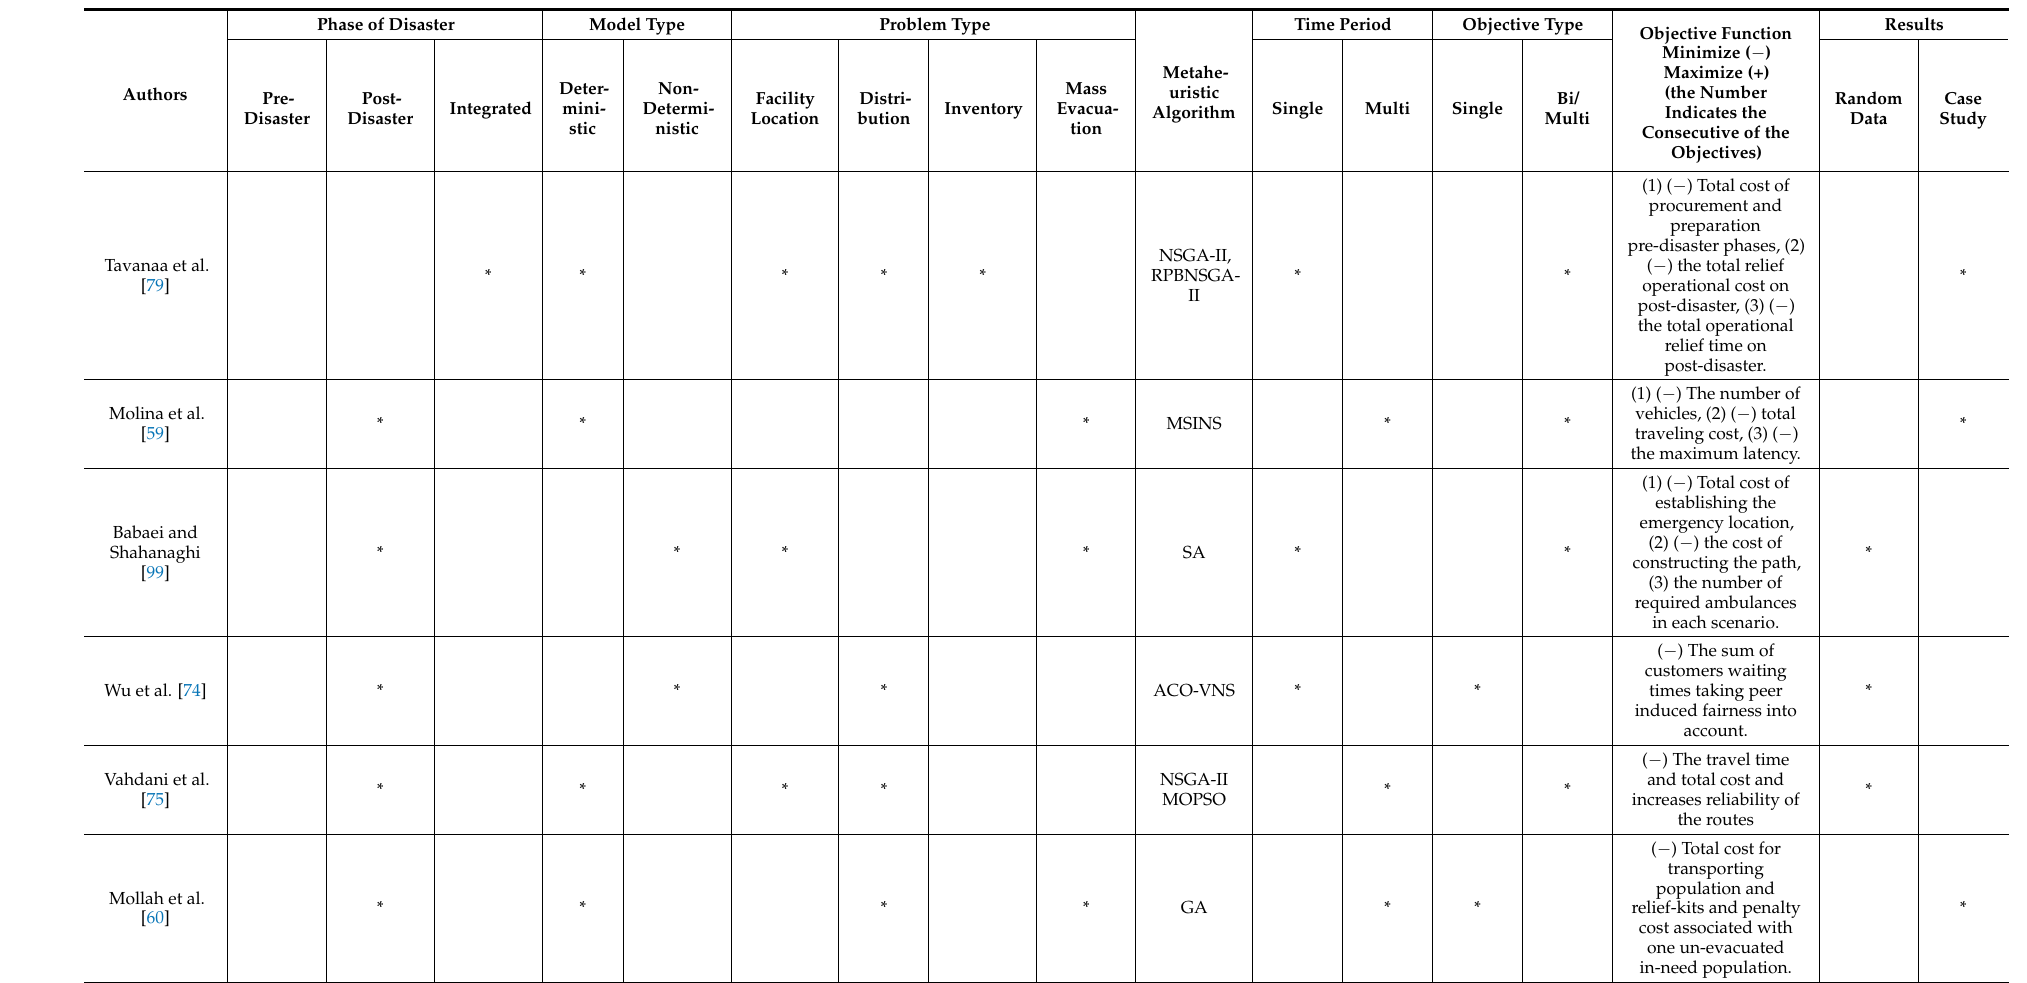
Table 1. Paper analysis, * means that the article meets this